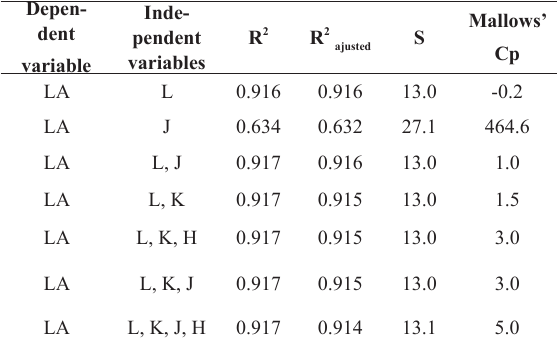
Application of the best subsets regression method between the leaf area (LA) and length (L) of the central lobe, the length and width product (K) length and number of lobes (J), length, width and number lobes (H) in cassava leaves, cultivar IAC 576-70, at 80 days after planting in the region of Botucatu, SP, Brazil.